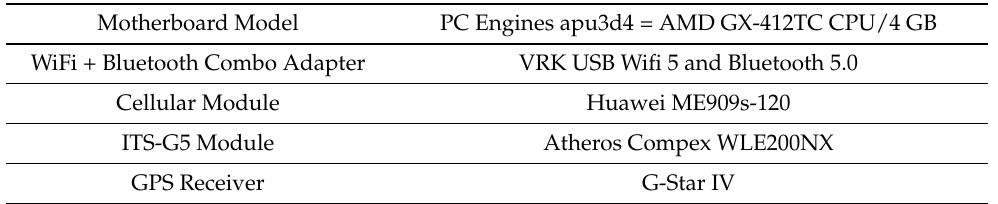
Table 2. OBU platform specifications.